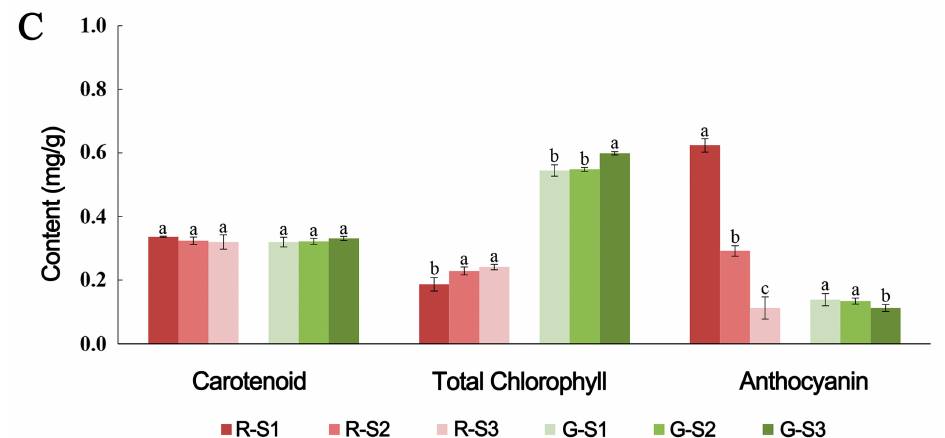
Figure 1. Leaf color parameters and pigment level of red-leaved P. bournei and green-leaved P. bournei. ( A ) Leaves of three developmental stages of different color P. bournei ; ( B ) Analysis of Variance (ANOVA) on leaf color parameters. Means of different treatment groups (different lowercase let- ters indicate significant differences) had a significant difference at p ≤ 0.05. ( C ) Chromophore (carotenoids, chlorophylls, anthocyanins) levels and contrast analysis. Means of different treatment groups (different lowercase letters indicate significant differences) had a significant difference at p ≤